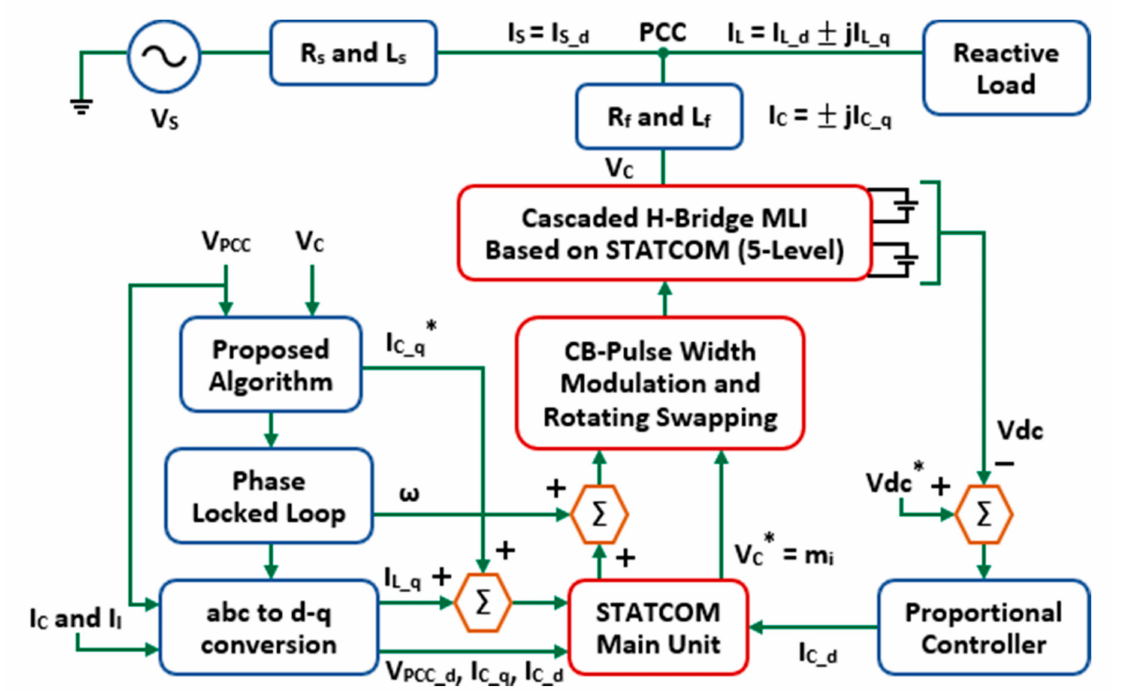
Figure 30. Block diagram for control technique for STATCOM